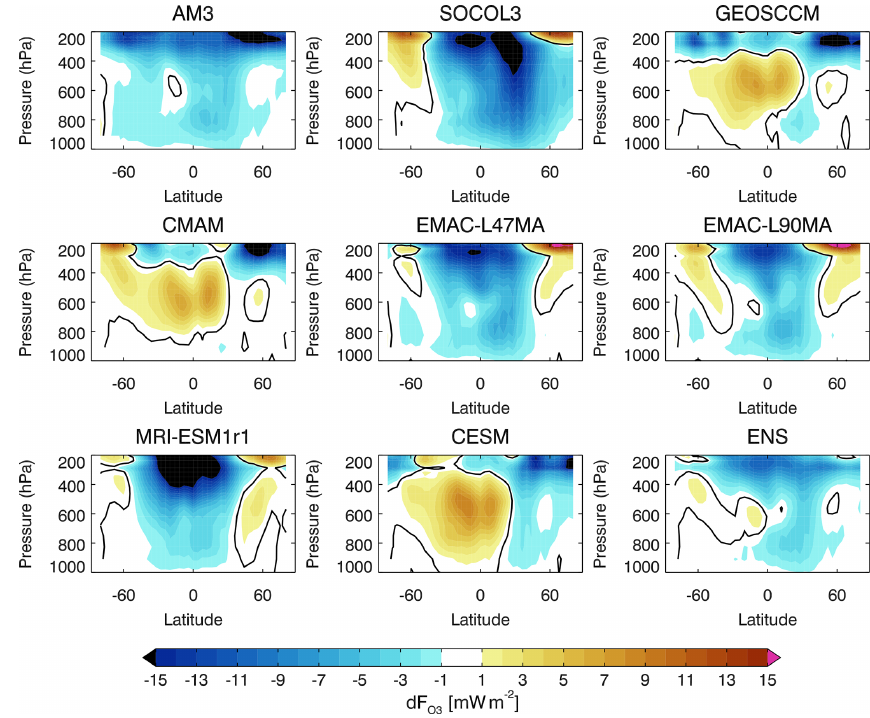
Figure 5. Vertical resolved O 3 radiative bias. The black curves are the zero lines.